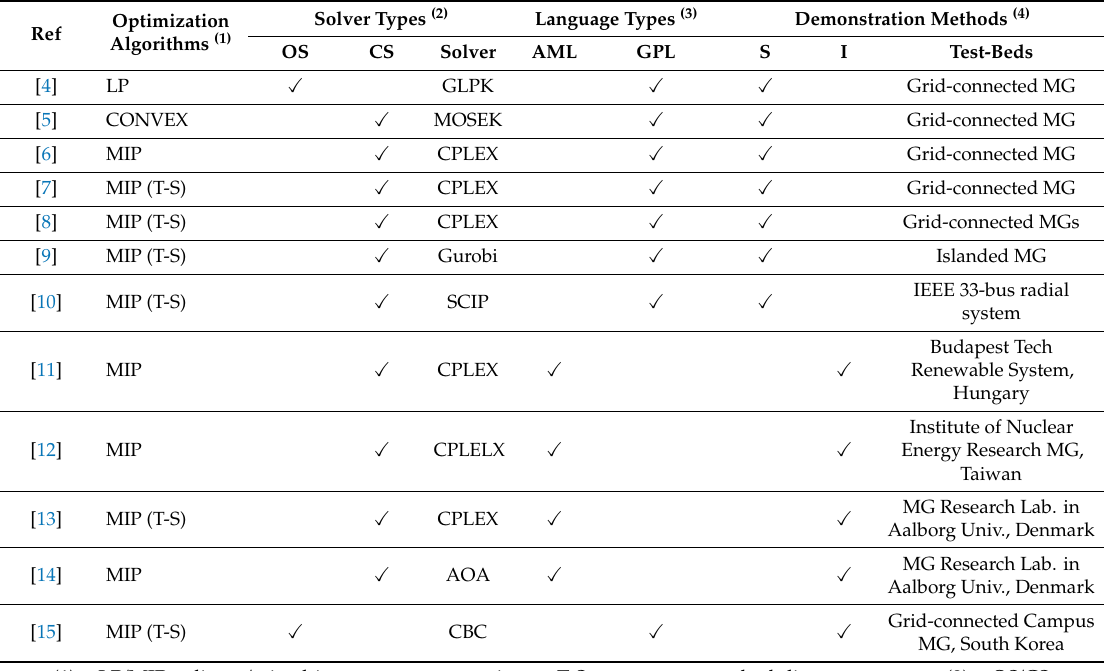
Table 1. Summary of previous studies on the implementation of economic dispatch (ED)